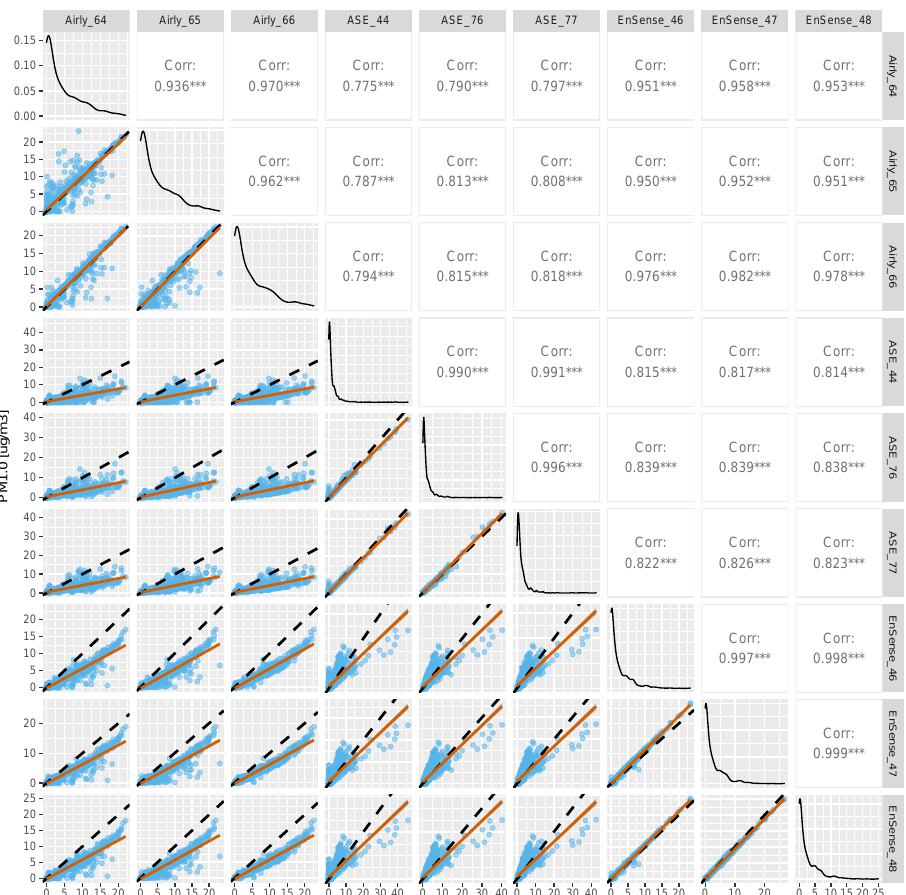
Figure 7. Sensor-to-sensor intercomparison of the factory-calibrated PM 1 signal of all sensors systems against each other during the co-location period. Axes labels are shown here in units of µg m − 3 . The lower left panels show scatterplots of one sensor’s output against the other (with the black dashed line indicating the 1:1 reference line and the red line a linear regression fit to the data). The panels on the diagonal show the probability density function of the readings of each individual sensors. The panels on the upper right show the Pearson correlation of the scatterplots on the lower left. *** means the correlation is